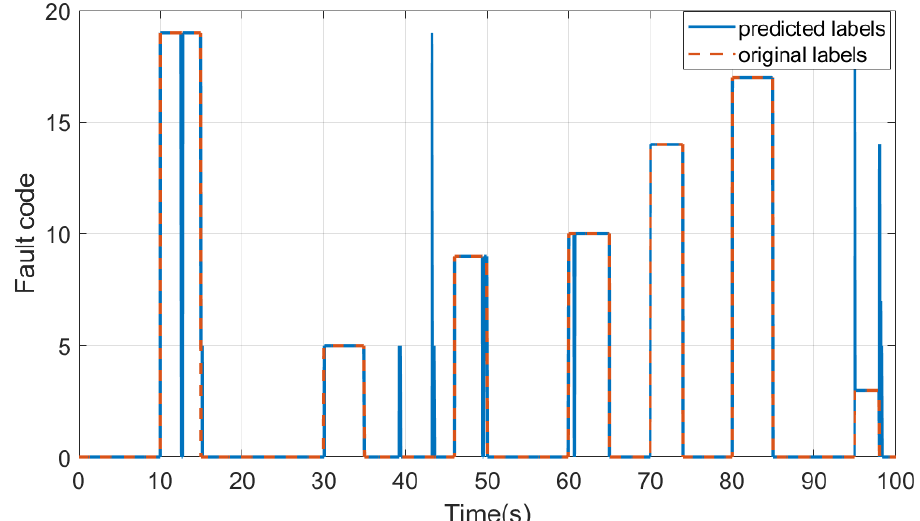
Figure 12. An example of the diagnosis results for six sensors: tie rod force sensor with a positive offset (19), steering wheel angle sensor with a negative offset (5), yaw rate sensor with a total loss (9), longitudinal acceleration with a positive offset (10), left wheel speed sensor with a negative offset (14), right wheel speed sensor with a negative offset (17) and steering wheel torque sensor with a total loss